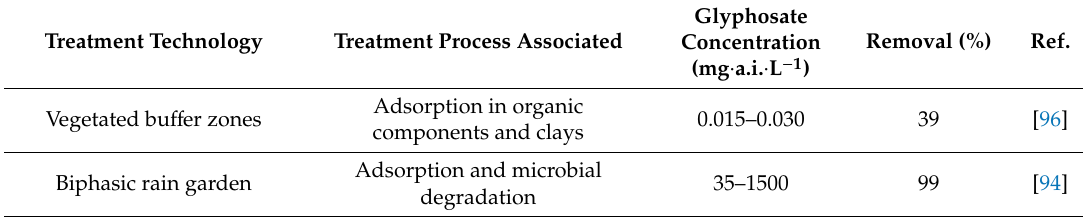
Table 5. Removal of glyphosate from water polluted by combined treatment